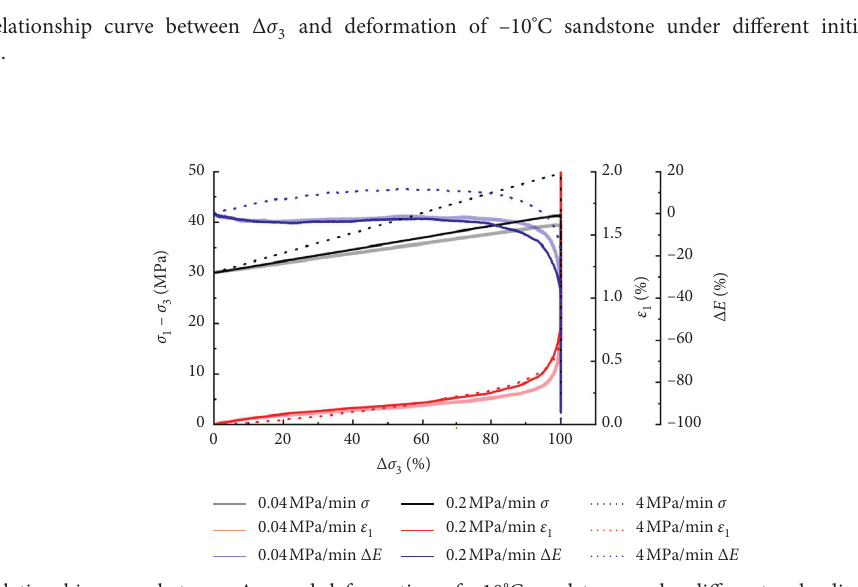
and deformation of − 10 ° C sandstone under different unloading rates ( σ 0 3